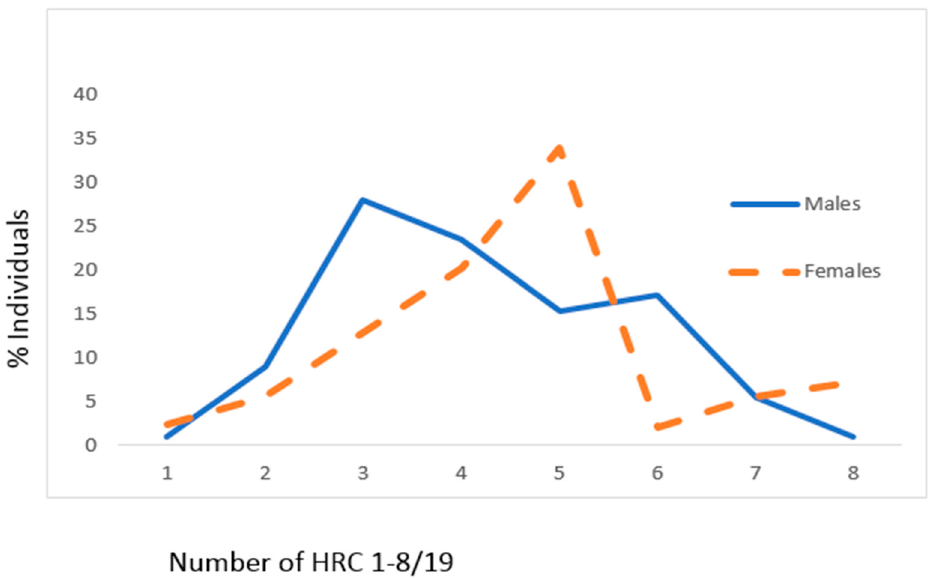
Figure 2. Frequencies of homozygous recessive characteristics (hrc) in males and females of the CAD sample. X—mean values with standard deviation, V—variability, z—Mann Whitney U test. Males: n = 111, x hrc/19 = 4.21 ± 1.47 (95% CI 3.93–4.48). Females: n = 124, x hrc/19 = 4.73 ± 1.60 (95% CI 4.44–5.00; z = 2.564, p = 0.010). V Males = 34.92%, V Females = 33.83%.